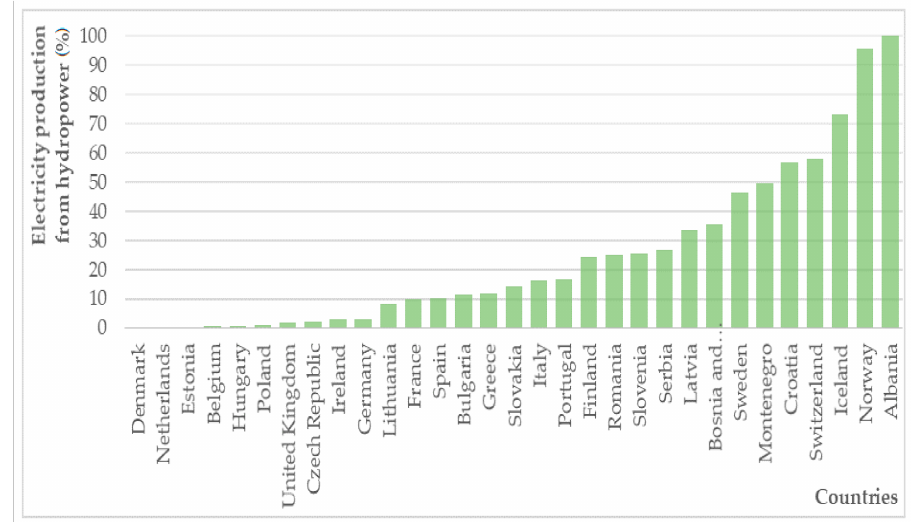
Figure 1. Share of domestic electricity production from hydropower in selected European countries (data based on [2]).